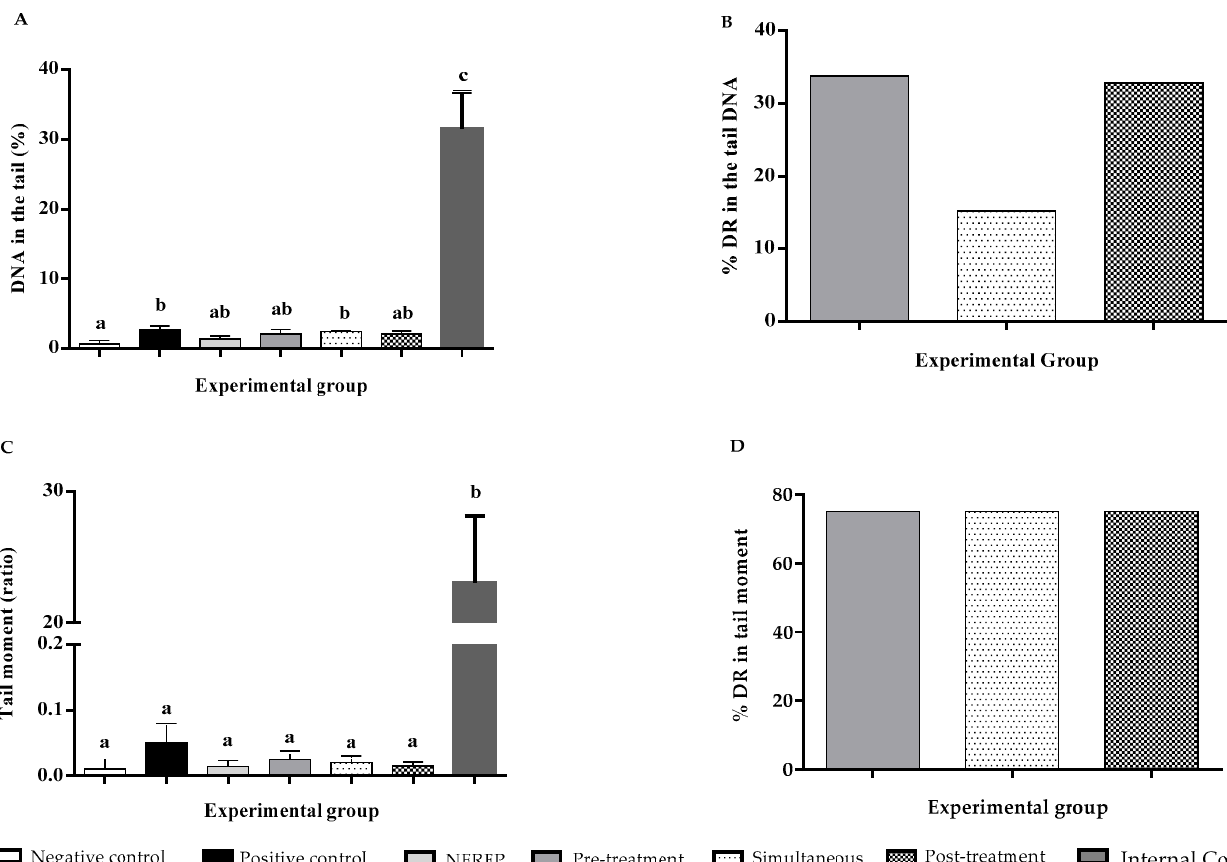
Figure 2. Chemopreventive action of Natural Fiber-Rich Food Product (NFRFP), by the comet assay, in different protocols for inducing DNA damage by 1,2-Dimethylhydrazine. ( A ) % DNA in the tail; ( B ) % Reduction of DNA damage in the tail DNA; ( C ) Moment of the tail; ( D ) % Reduction of damage in tail moment. Internal Control—was performed with B16F10 cells treated with doxorubicin (5 µM). Different letters indicate statistically significant differences (Statistical Test: ANOVA/Tukey; p < 0.05).